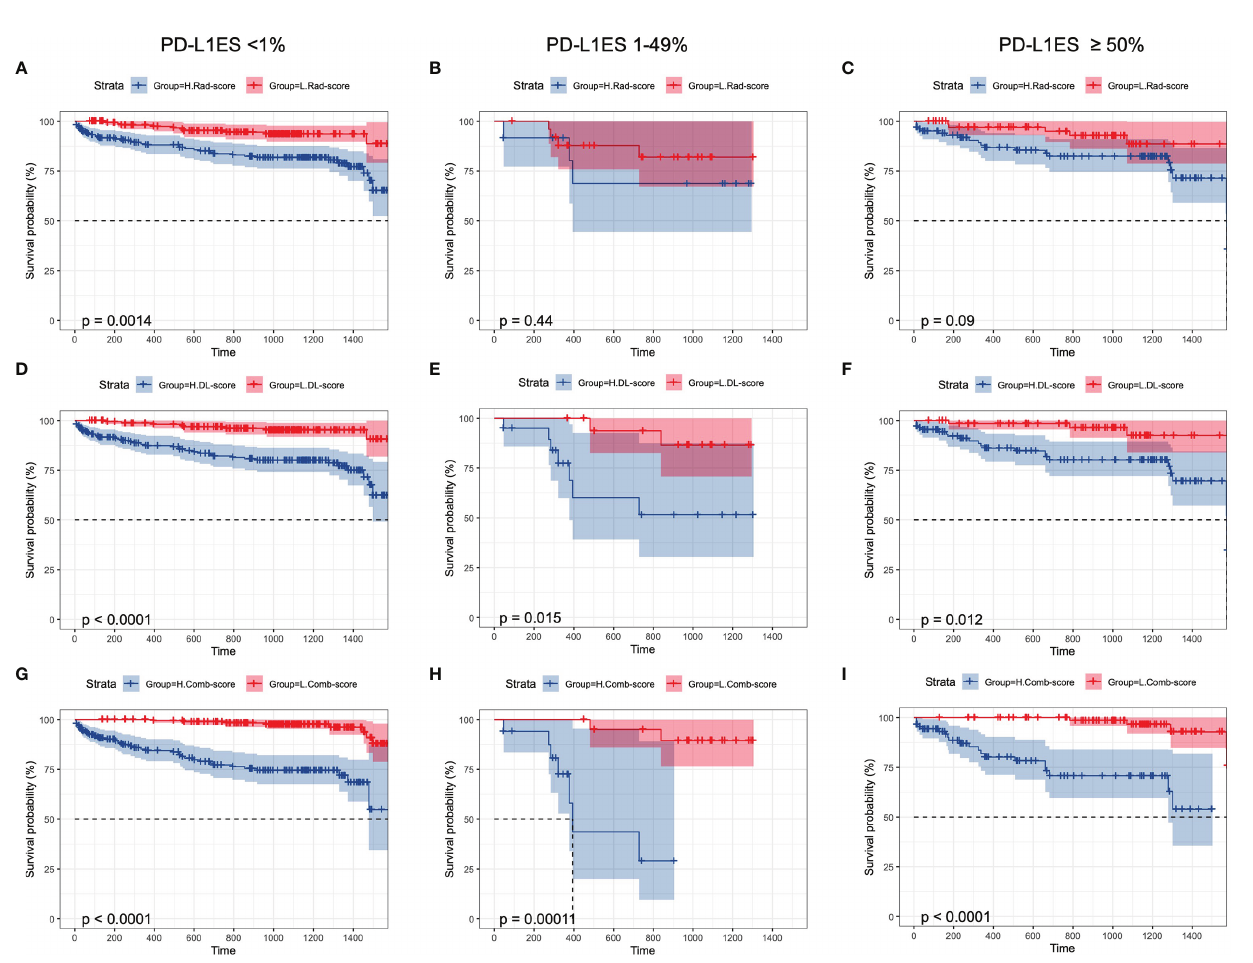
FIGURE 5 | Kaplan – Meier curves of overall survival prediction in different PD-L1 ES groups. K – M curves were strati fi ed by (A – C) Rad-score, (D – F) DL-score, (G – I) : combination-score to identify high-risk and low-risk groups. PD-L1ES, PD-L1 expression signature; Rad, radiomics; DL, deep